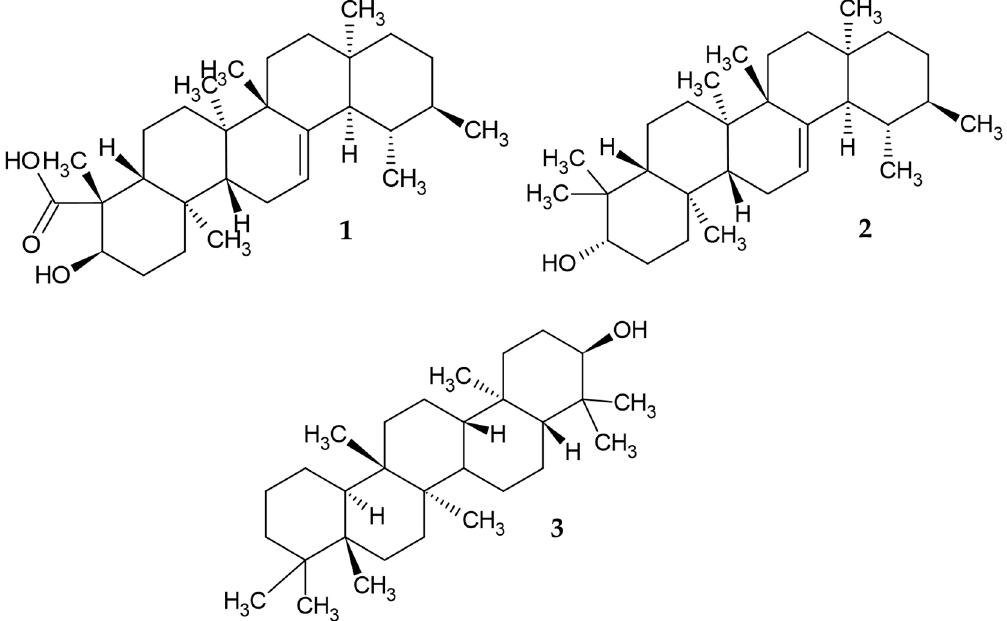
Figure 1. Terpenoids identified in the active fraction of MA-24F in leaves of M. alceifolia by GC-MS. These are the compounds with the best score protein-ligand interactions in L. mexicana proteins .